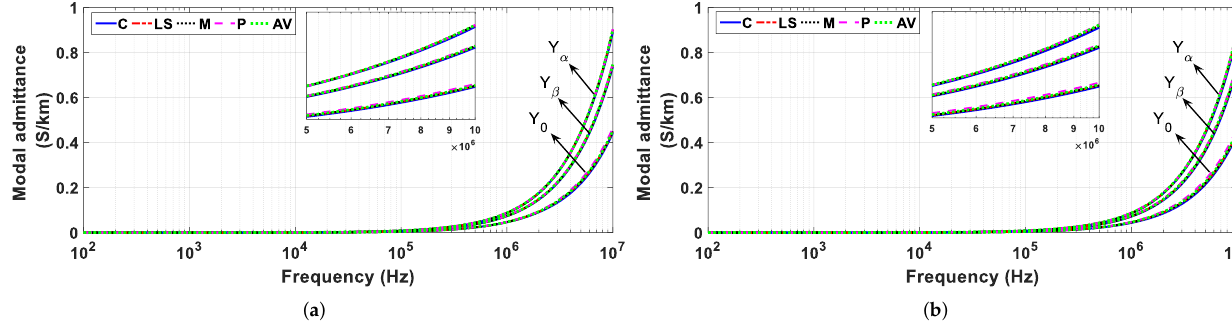
Figure 10. Magnitude of the modal admittance for a soil of: ( a ) 700 Ω · m and ( b ) 4000 Ω ·